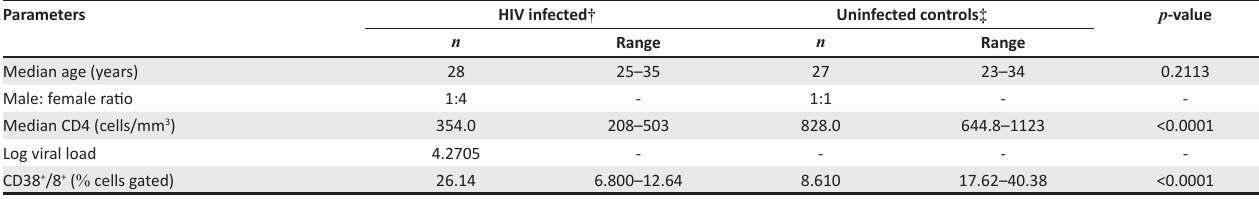
TABLE 1: Participants’ demographics and disease parameters.